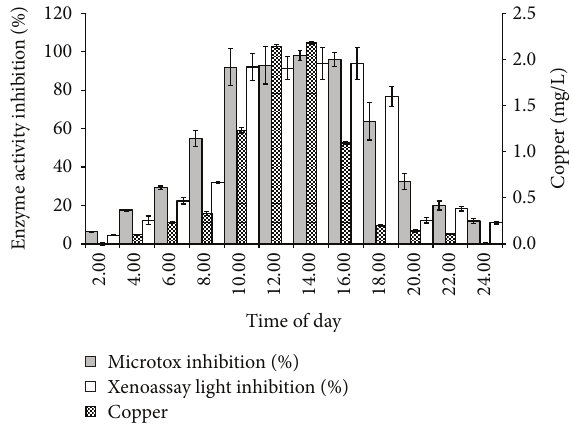
Figure 12: Inhibition of bioluminescence activity of Microtox and Xenoassay Light assays and copper concentration in water samples. Data is mean standard error of the mean ( 𝑛 = 3